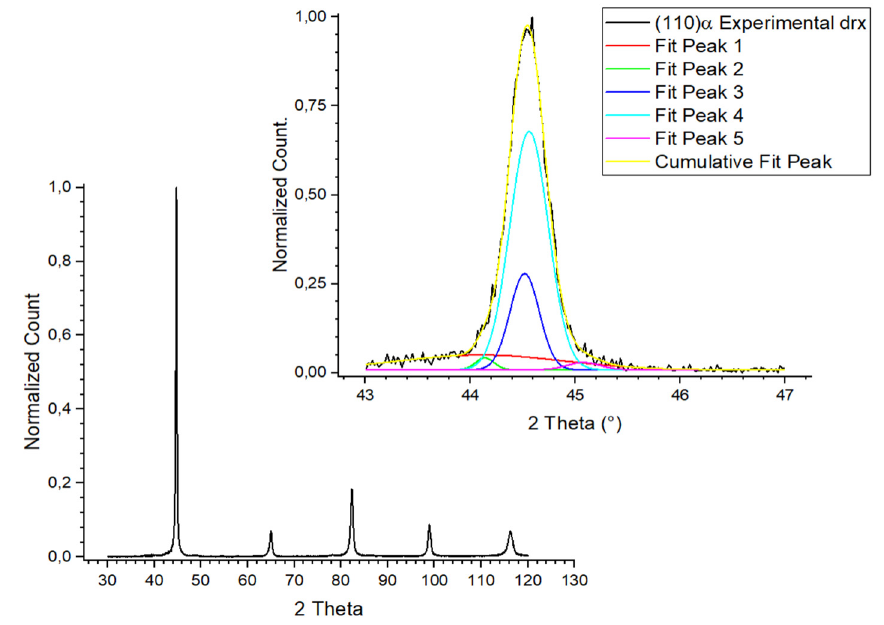
Figure 6. XRD patterns of the SOHIC tested specimen . Table 2. Peak parameters such as crystallite size (D), dislocation density ( δ ), micro-strain ( ε ) for five sub-peaks using the self-made numerical process of Gaussian multiple of the SOHIC tested speci- men .